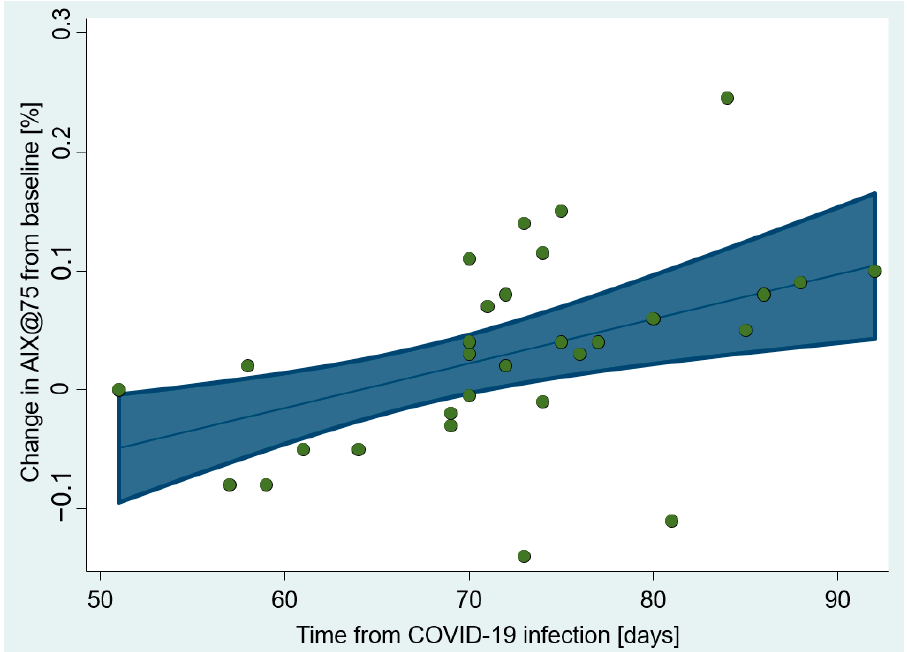
Figure 2. The change in AIx normalized to the heart rate of 75 bpm (AIx@HR75) from the baseline depends on the time that passed from acquiring COVID-19 infection. Shown are predictive margins with 95% CI estimated by the LR model (R 2 = 26%) and the scatter plot of